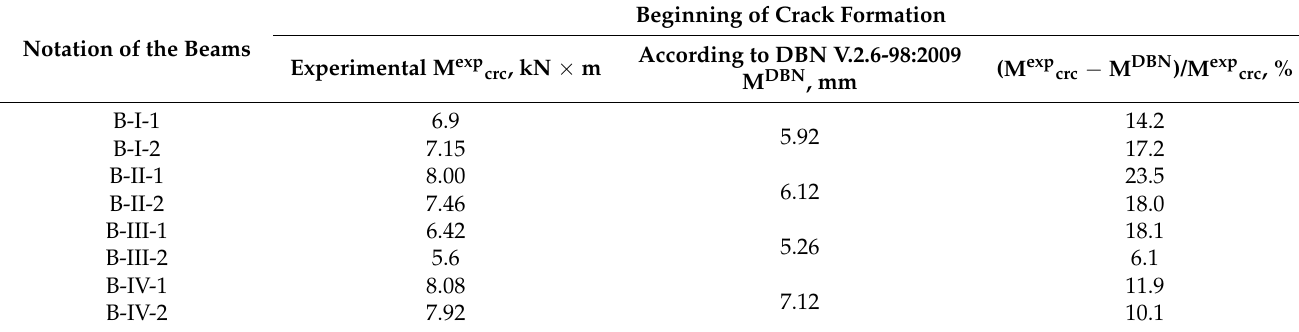
Table 2. Comparison of moments corresponding to crack